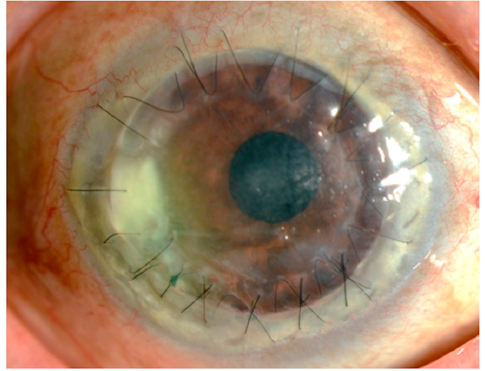
Figure 1. Slit lamp photograph. An 89-year-old man who underwent a penetrating keratoplasty at his age of 81. The corneal infiltration was observed around the graft suture, accompanied with moderate hyperemia.